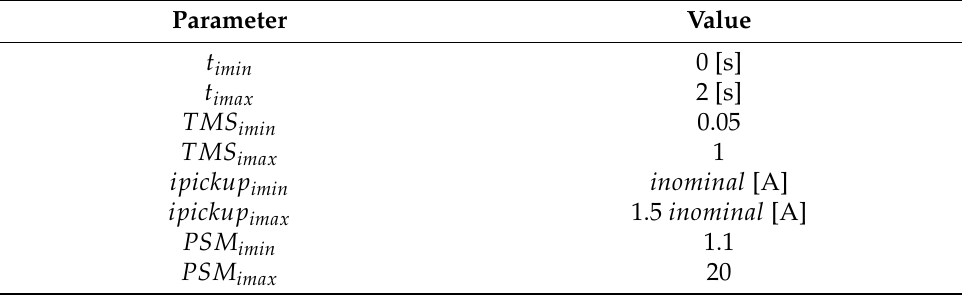
Table 1. Input parameters.